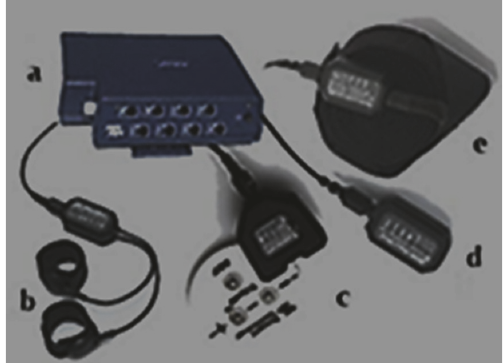
Figure 2: The Biography Infiniti.